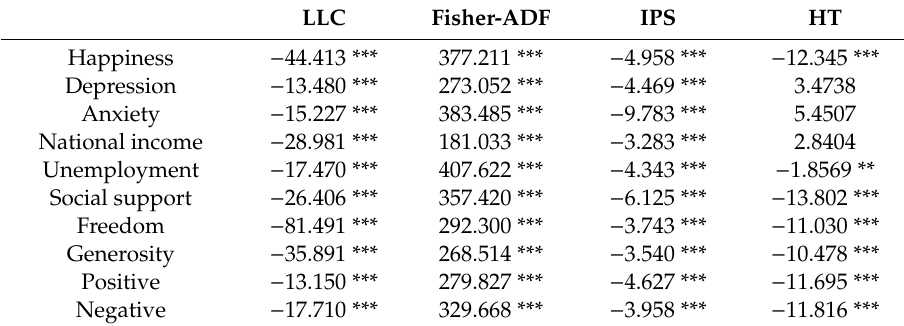
Table 3. Results of panel unit root